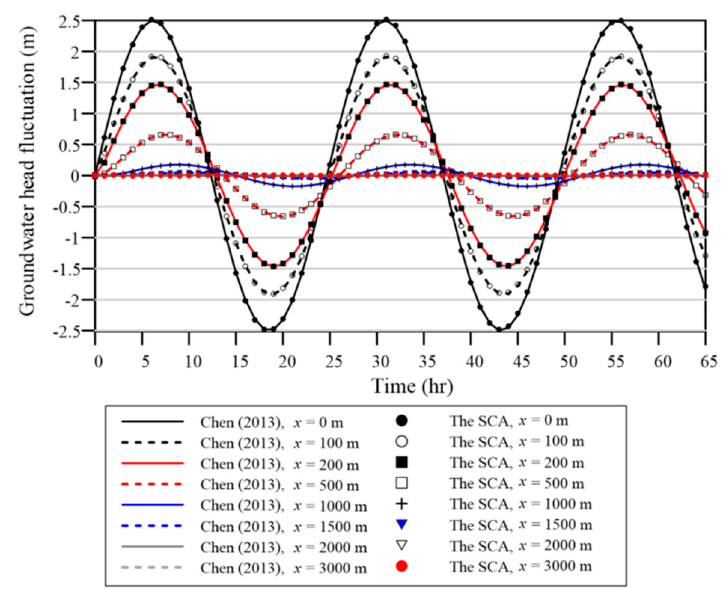
Figure 9. Result comparison of example 3 (case A).